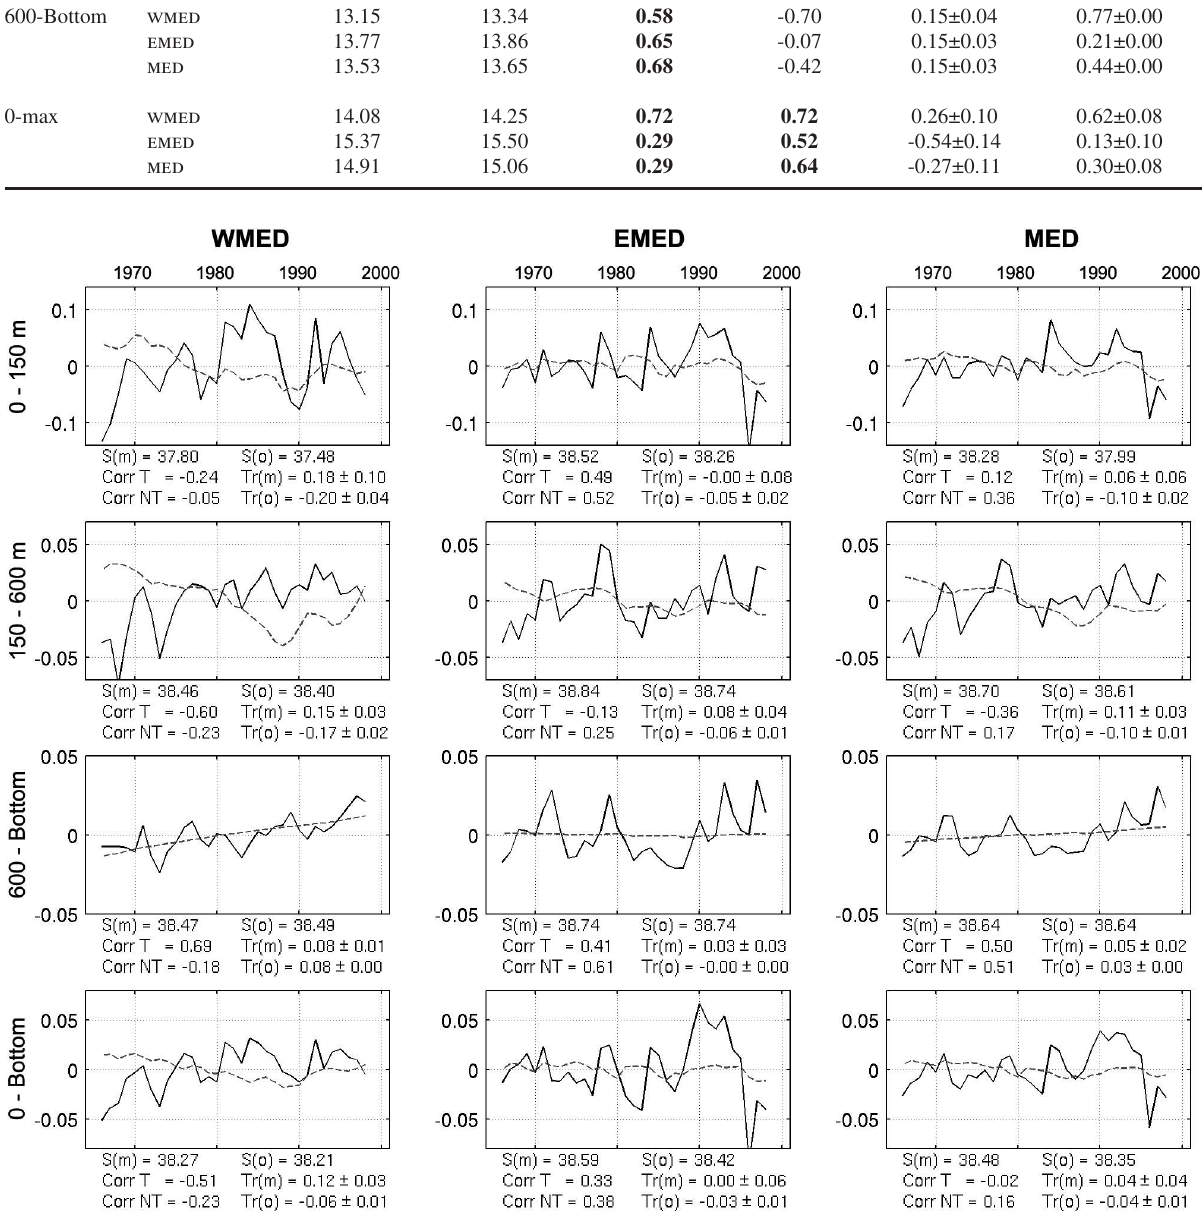
Fig . 3. – ORCA (o) (dashed-line) and MEDAR (m) (solid-line) salinity timeseries divided into basins and layers (1965-1998). S refers to the mean temperature. Corr T refers to the correlation of the time-series with their respective trends. Corr NT refers to the de-trended correlation values. Tr refers to the trend